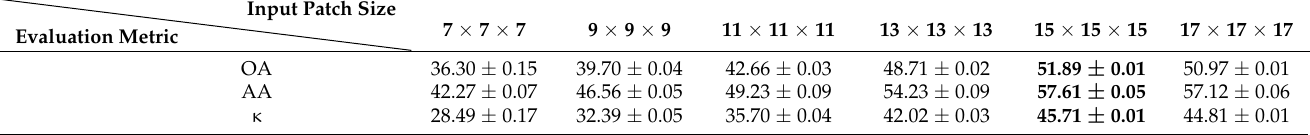
Table 4. Classification performance of 3D-FHOG with different input patch sizes on IP data set.